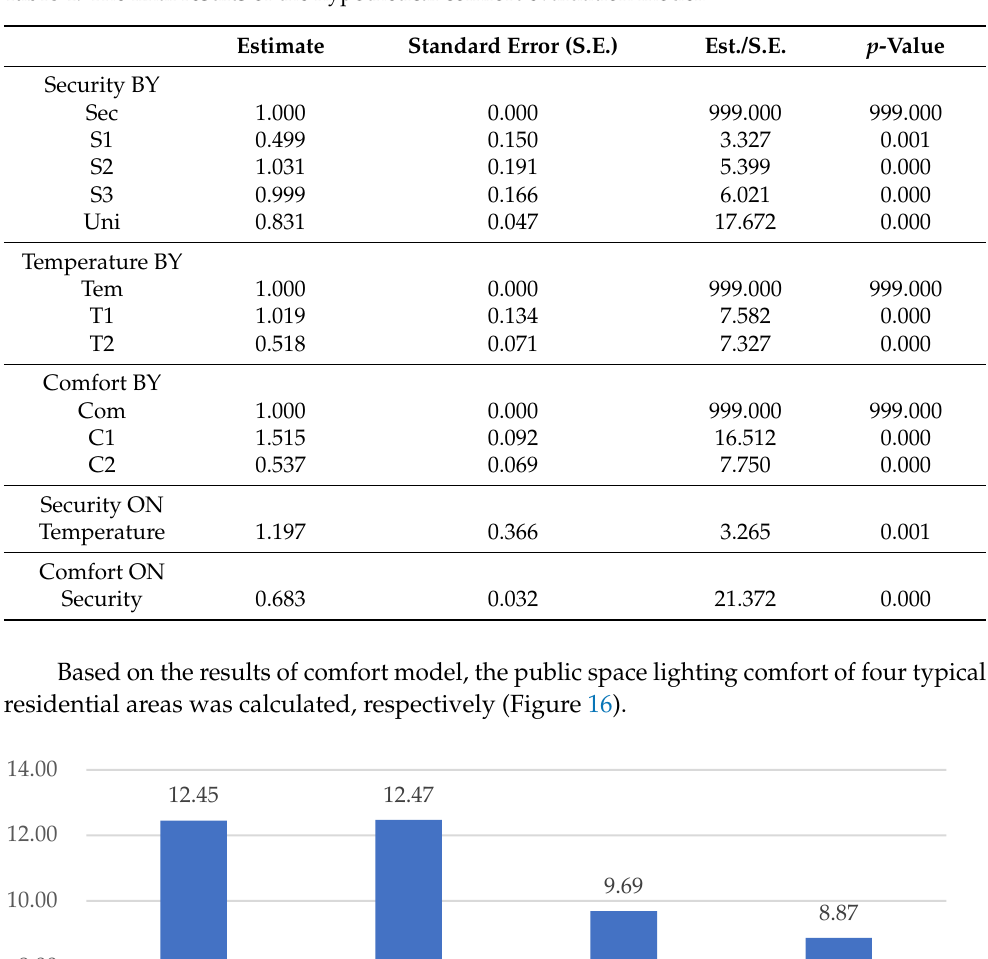
Table 4. The final results of the hypothetical comfort evaluation model.